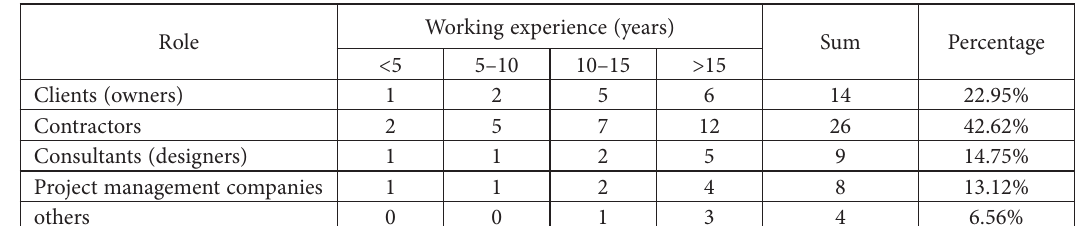
Table 2. Profiles of survey respondents